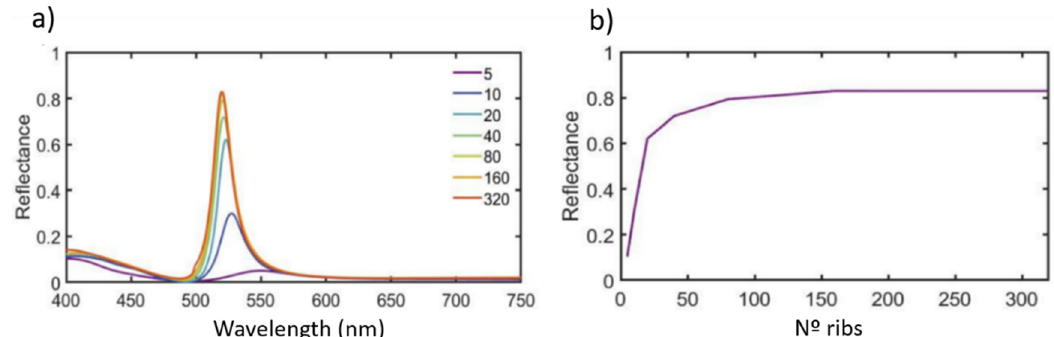
Figure 3. ( a ) Spectral reflectivity of the proposed device fixing grating parameters to d = 150 nm, P = 340 nm, and D = 0.6 ( on state) for different numbers of ribs. ( b ) Maximum reflectance of the resonances generated by changing the number of ribs.